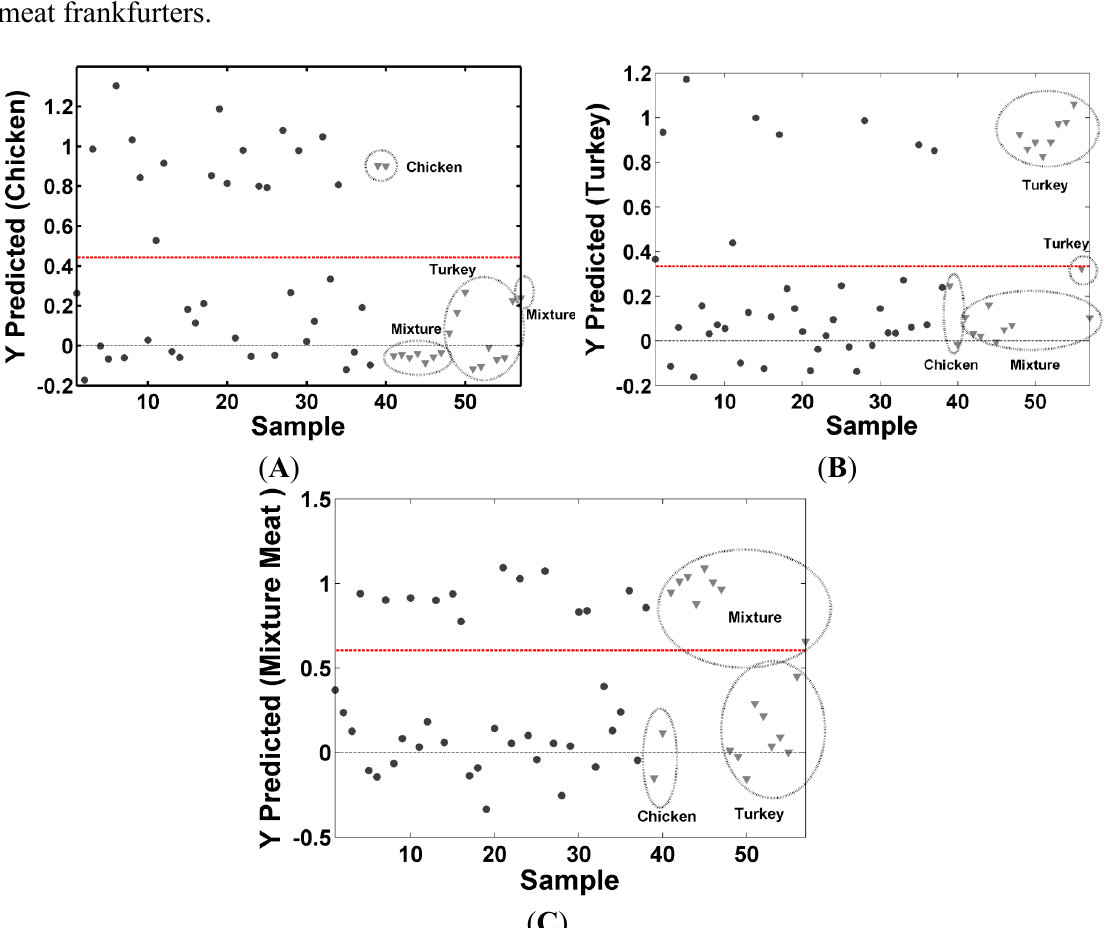
Figure 4. Results of the training and test set of the PLS-DA model: ● (training samples), ▼ (test samples); ( A ) chicken frankfurters; ( B ) turkey frankfurters and ( C ) Mixture meat